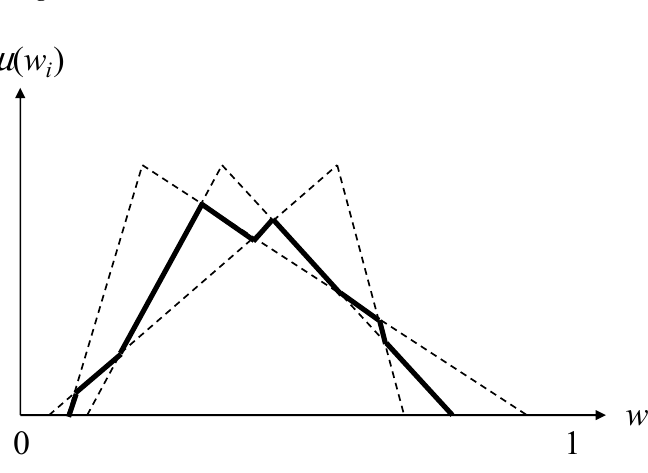
Figure 4. The 2/3 partial consensus fuzzy intersection (PCFI) result.